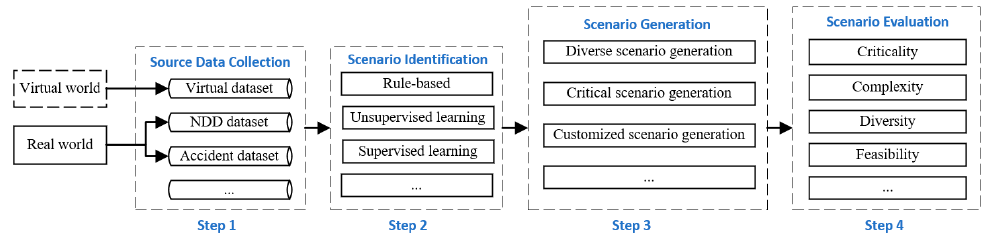
Figure 1. A typical framework of the data-driven scenario generation